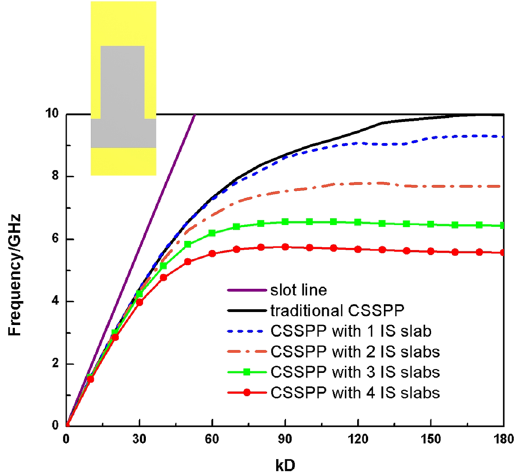
Figure 2. Dispersion properties of slot line (purple line), traditional CSSPP waveguide (black line) and novel design with one (blue dashed line), two (orange dash dot line), three (green line with squares) and four (red line with dots) IS slabs loaded. Inset: one unit of the traditional